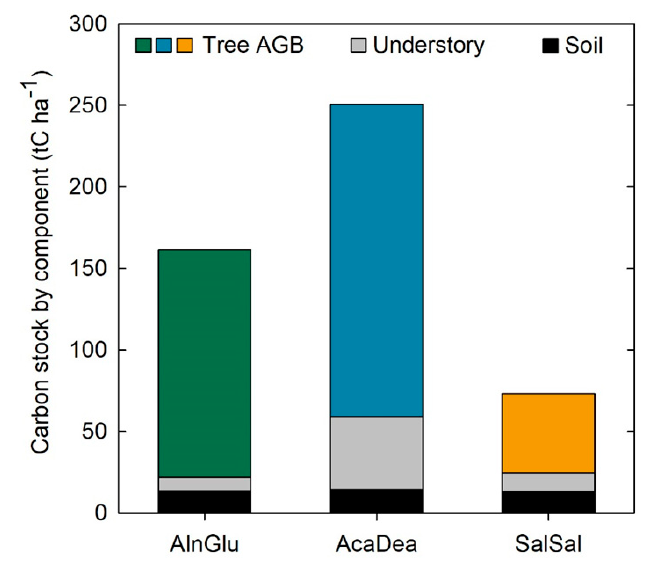
Figure 4. Carbon stocks of Alnus glutinosa (AlnGlu), Acacia dealbata (AcaDea) and Salix salviifolia. (SalSal) woodlands by component. AGB—aboveground biomass.